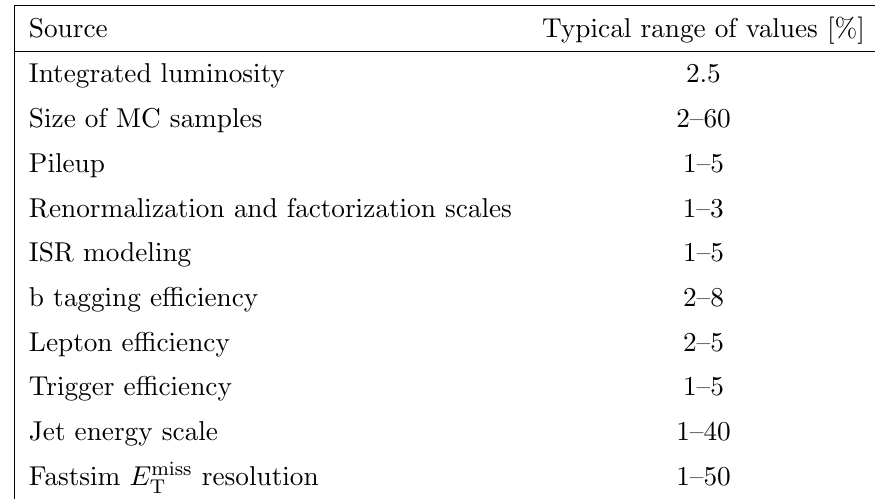
Table 3 . Sources of systematic uncertainty in the estimated signal yield, along with their typical values. The ranges represent variation across the signal masses probed.